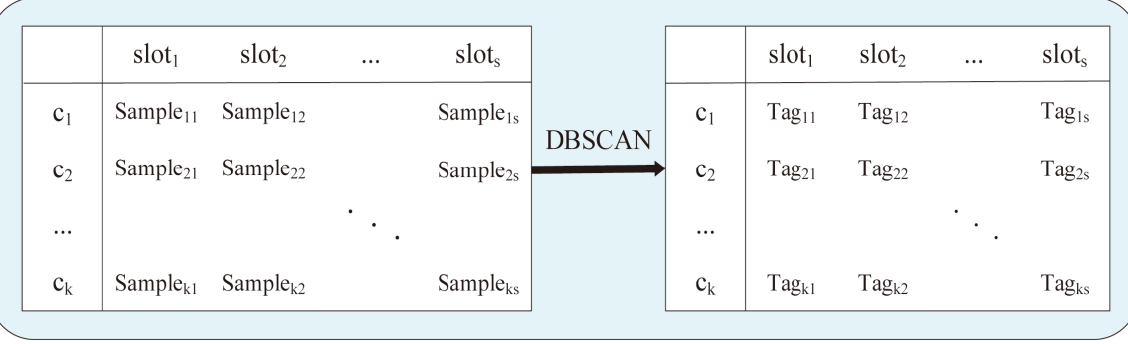
Figure 4. Outlier points detection based on DBSCAN.